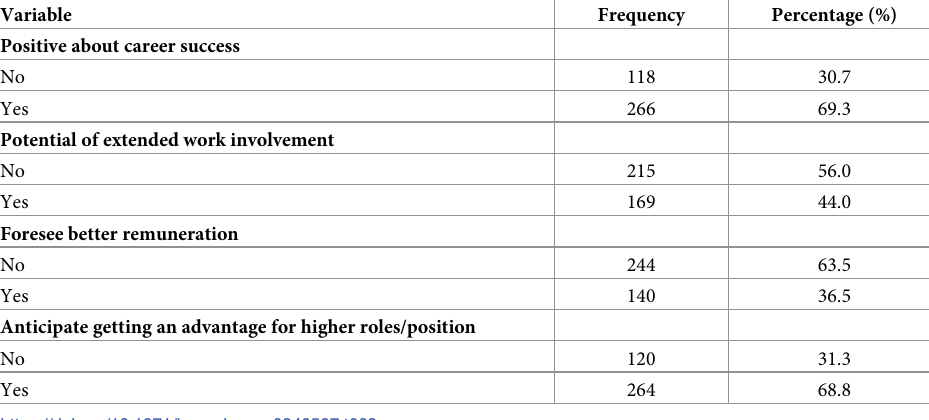
Table 2. Prospects with waiting at upscale restaurant.